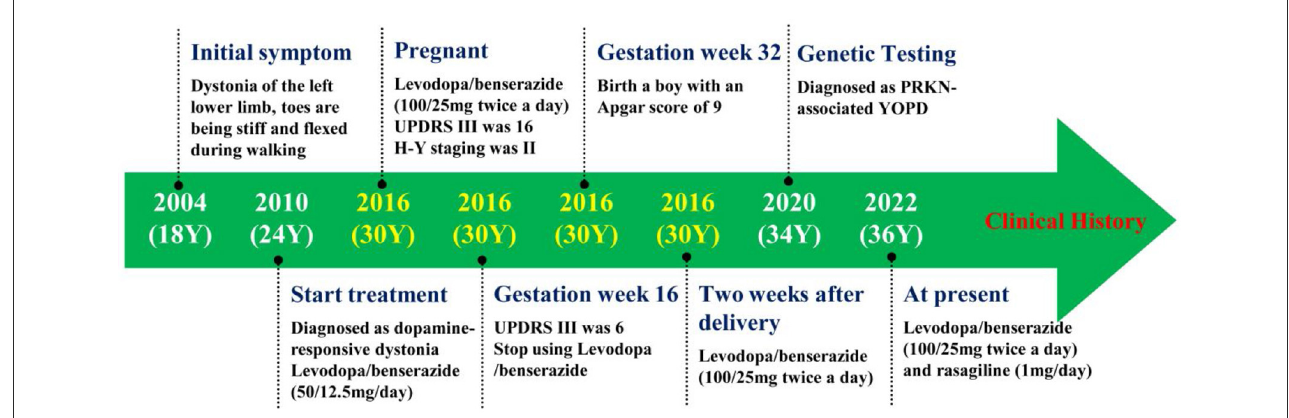
FIGURE2 The figure showing the patient’s clinical history. Y, years old; UPDRS III, Unified Parkinson’s Disease Rating Scale motor section; H-Y, Hoehn and Yahr; YOPD, Young-Onset Parkinson’s